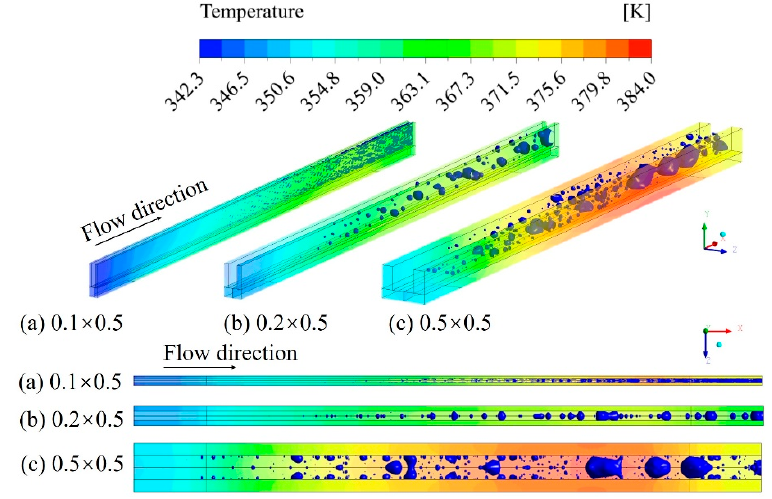
Figure 14. The quasi-steady-state solutions for temperature field and the two-phase flow regime for different channel widths.